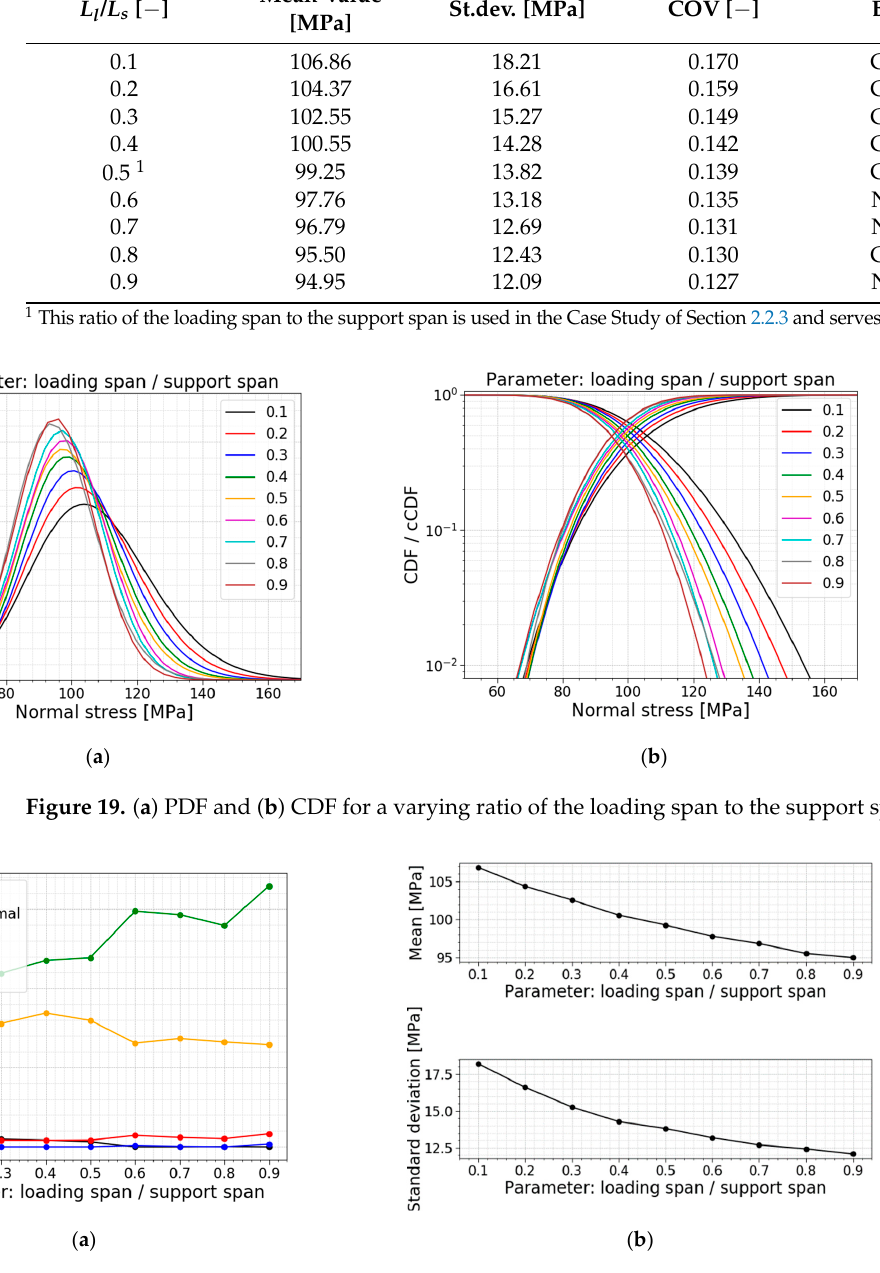
Figure 20. ( a ) AIC values and ( b ) the mean and st.dev. of the normal stress at failure for a varying ratio of the loading span to the support